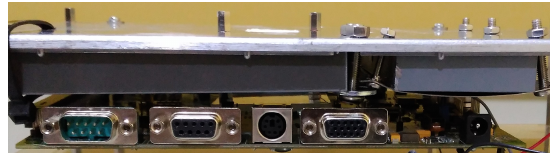
Figure 3. Profile view of the shielding between the PCB and the cover of the filter box.